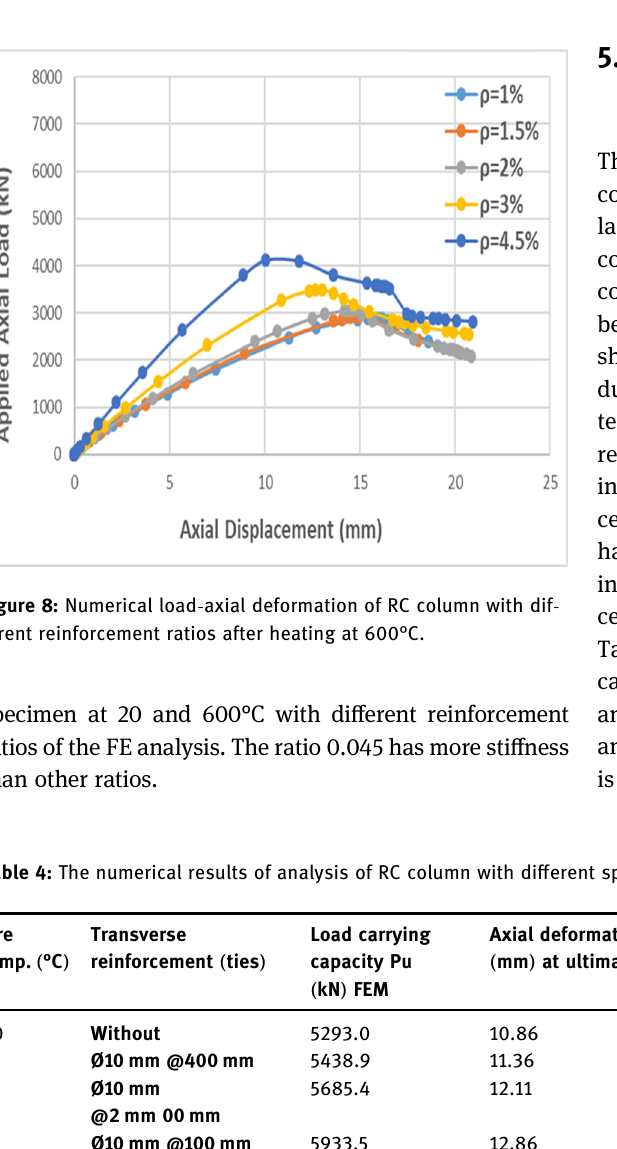
Table 5: Numerical results of exposed RC columns at 600°C and various fi re exposure durations